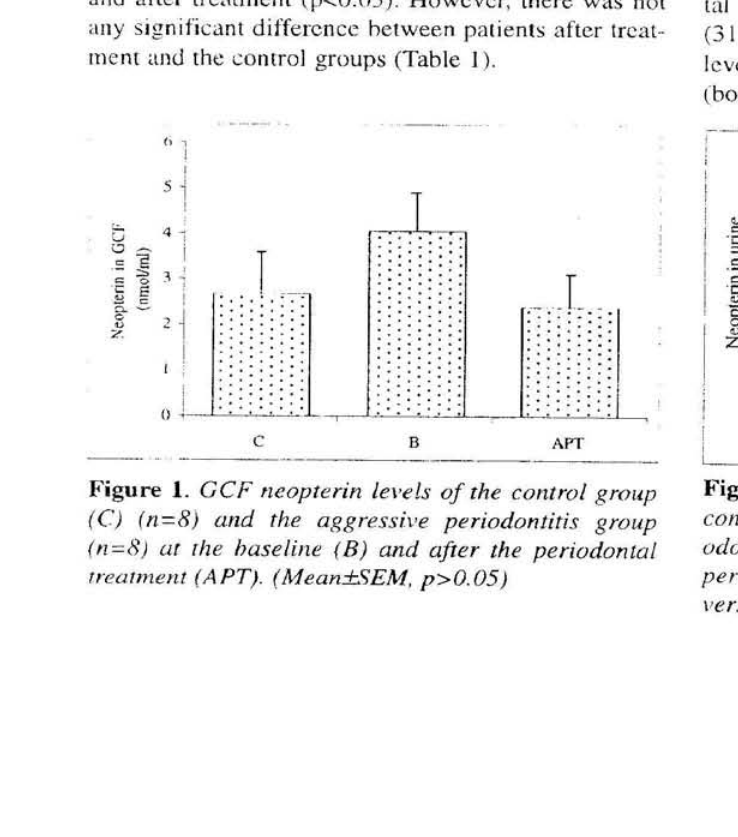
baseline levels (Fig. 2).